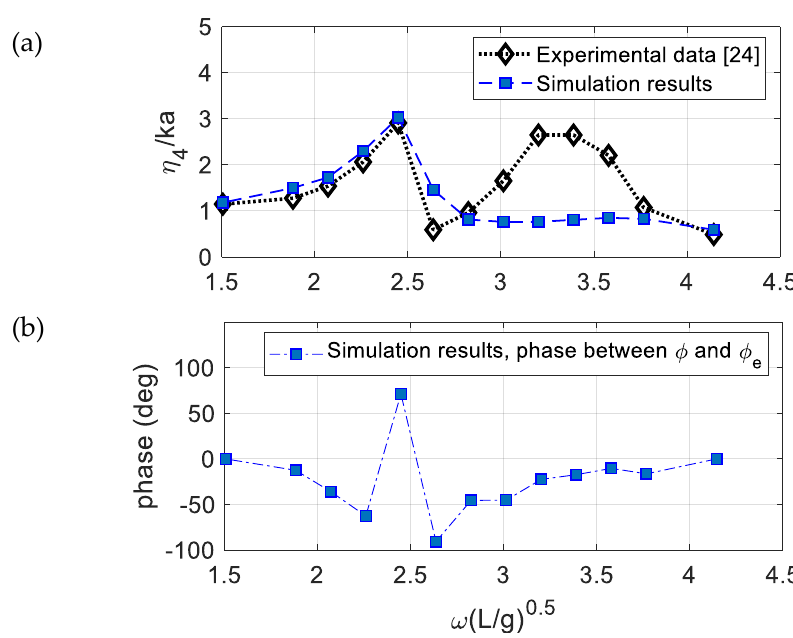
Figure 9. Roll RAO for the flooded ship in beam waves ( a ) (numerical vs. experimental) and phase angles ( b ) (numerical only).